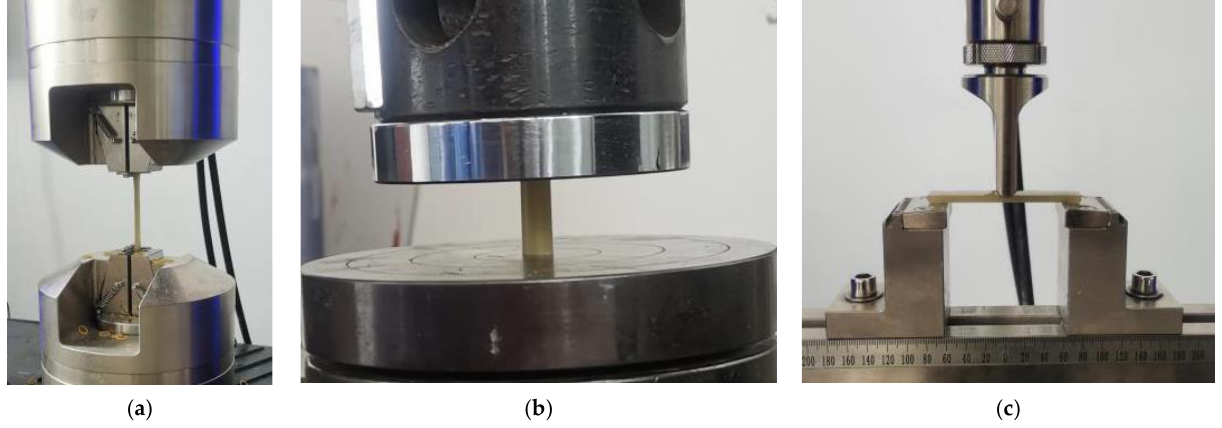
Figure 3. Epoxy resin and epoxy resin mortar material property test. ( a ) Tensile test; ( b ) compression test; ( c ) bending test. Table 2. Performance parameters of epoxy resin and epoxy resin mortar material.